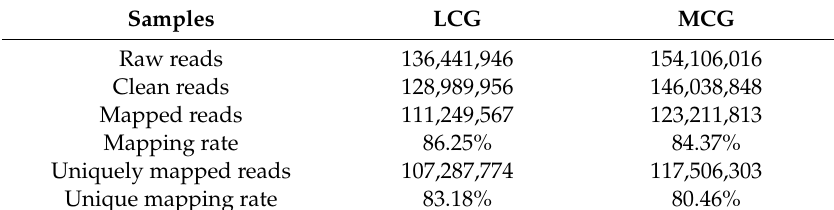
Table 1. Summary of reads mapping to the goat reference genome.1